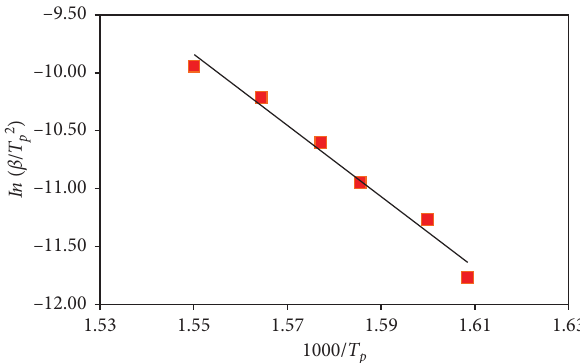
Figure 3: Kissinger plot ln ( β / T 2 PNVP- co -PSMA 40–60.